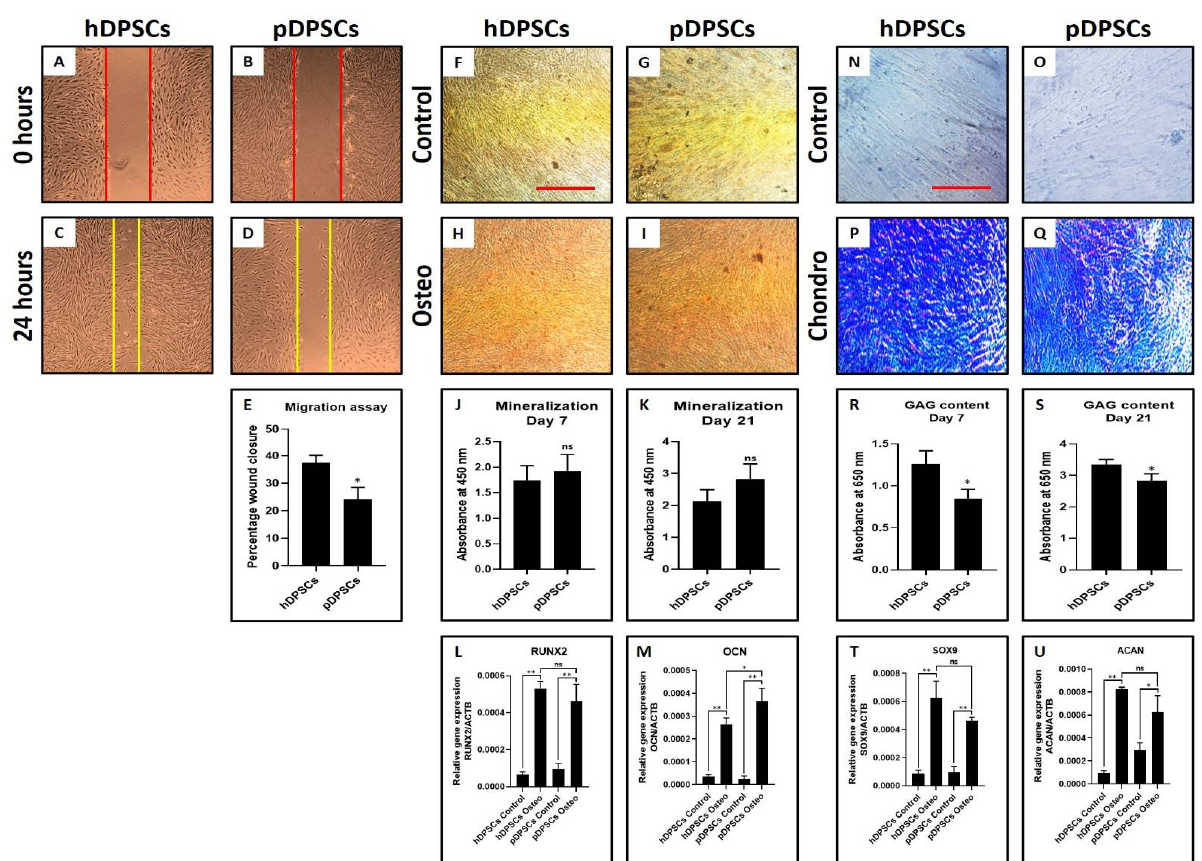
Figure 2. Assessment of migration, osteogenic differentiation and chondrogenic differentiation in DPSCs from healthy and periodontitis-affected teeth at Passage 2. ( A – E ) comparative analysis of the migratory ability of hDPSCs and pDPSCs. ( F – I ) comparative analysis of osteogenic differentiation in hDPSCs and pDPSCs. ( J , K ) comparative analysis of mineralization in osteogenically induced hDPSCs and pDPSCs at day 7 and day 21. ( L , M ) comparative analysis of